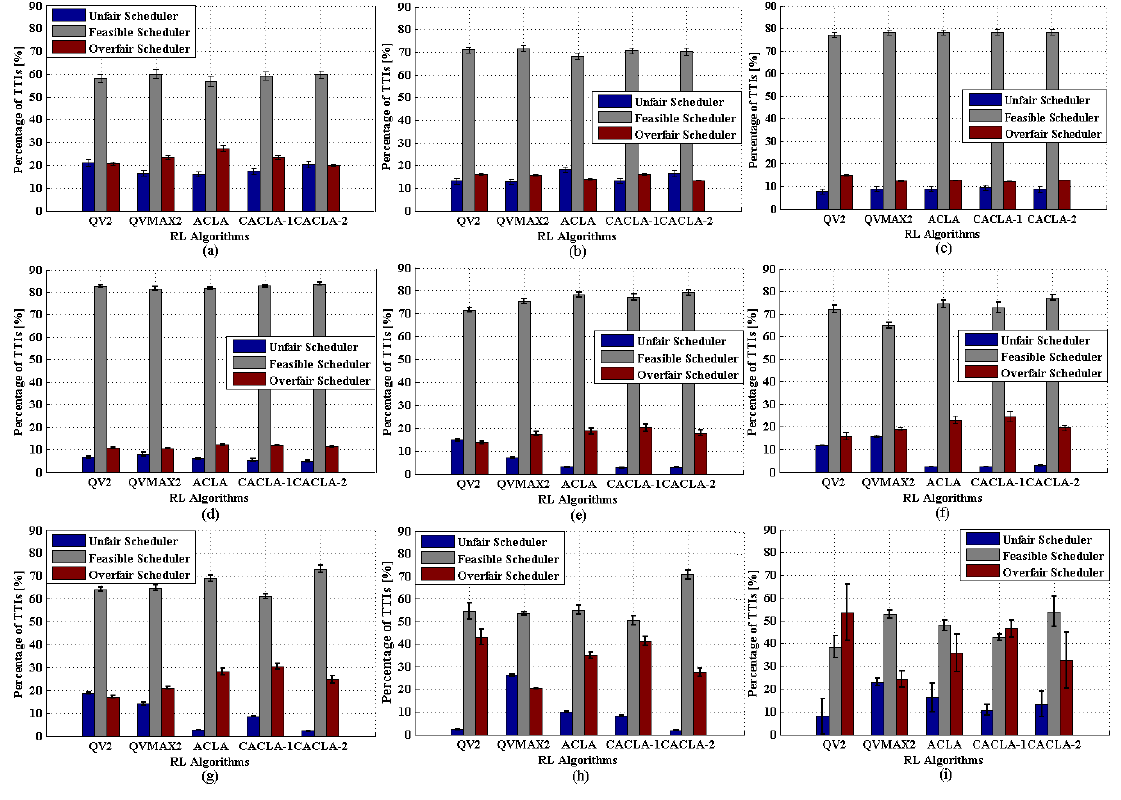
Figure 6. CACLA-2 vs. other RL Candidates: ( a ) ρ = 2.0; ( b ) ρ = 2.25; ( c ) ρ = 2.5; ( d ) ρ = 3.0;